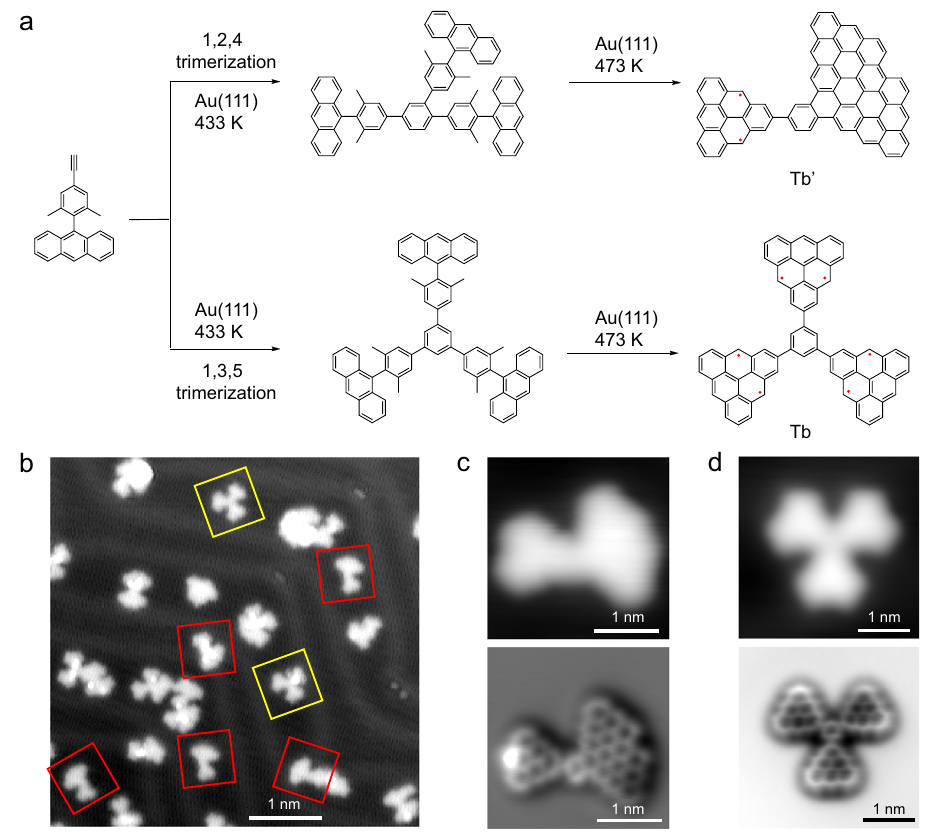
Fig. 2 Chemical structure characterization of products via trimerization of precursors with alkynes terminals. a Possible on-surface reactions for the main products. b Overview STM image after annealing precursor on Au(111) at 433 K and 473 K sequentially. c , d Zoom-in STM and AFM images of two main products on Au(111) with CO tip. Setpoint: V = 300 mV, I = 30 pA; Δ z = 0.02